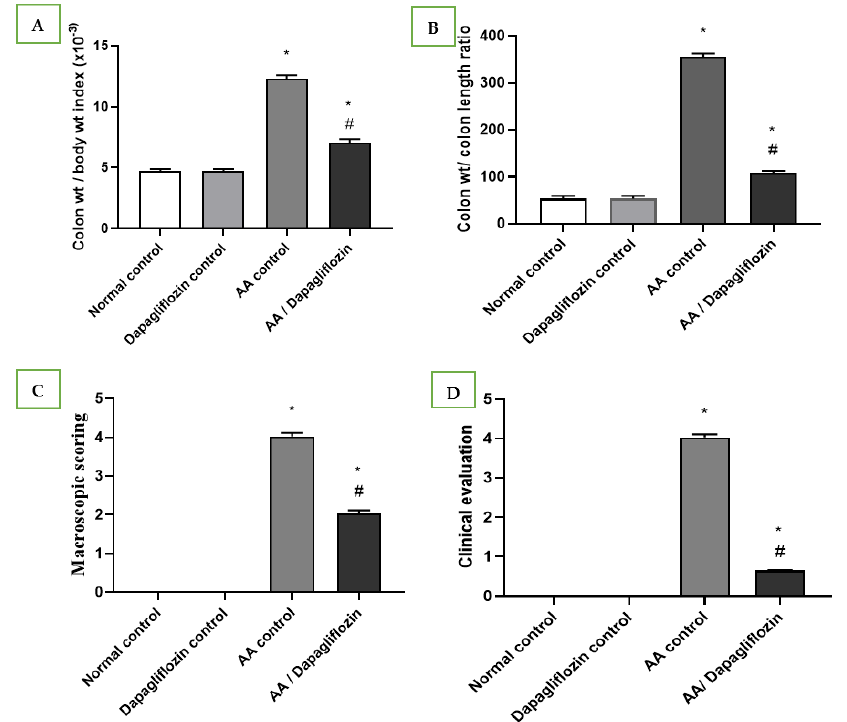
Figure 1. Effect of DAPA on AA-induced change in ( A ) Colon/body weight index, ( B ) Colon weight/colon length ratio, ( C ) Macroscopic scoring, and ( D ) cCinical evaluation. Data are expressed as mean ± SEM. Superscript characters reveal significant differences determined using one-way analysis of variance (ANOVA) followed by the Tukey–Kramer multiple comparison test (* p ˂ 0.05, DAPA compared with the normal control group; # p ˂ 0.05, DAPA compared with AA control group).